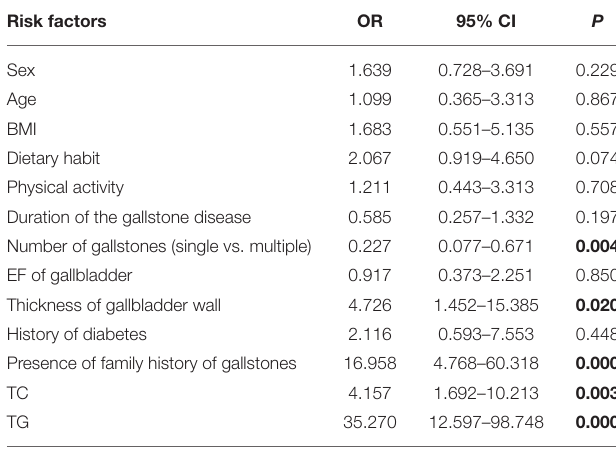
TABLE 2 | Results of chi-square test of postoperative gallbladder stone